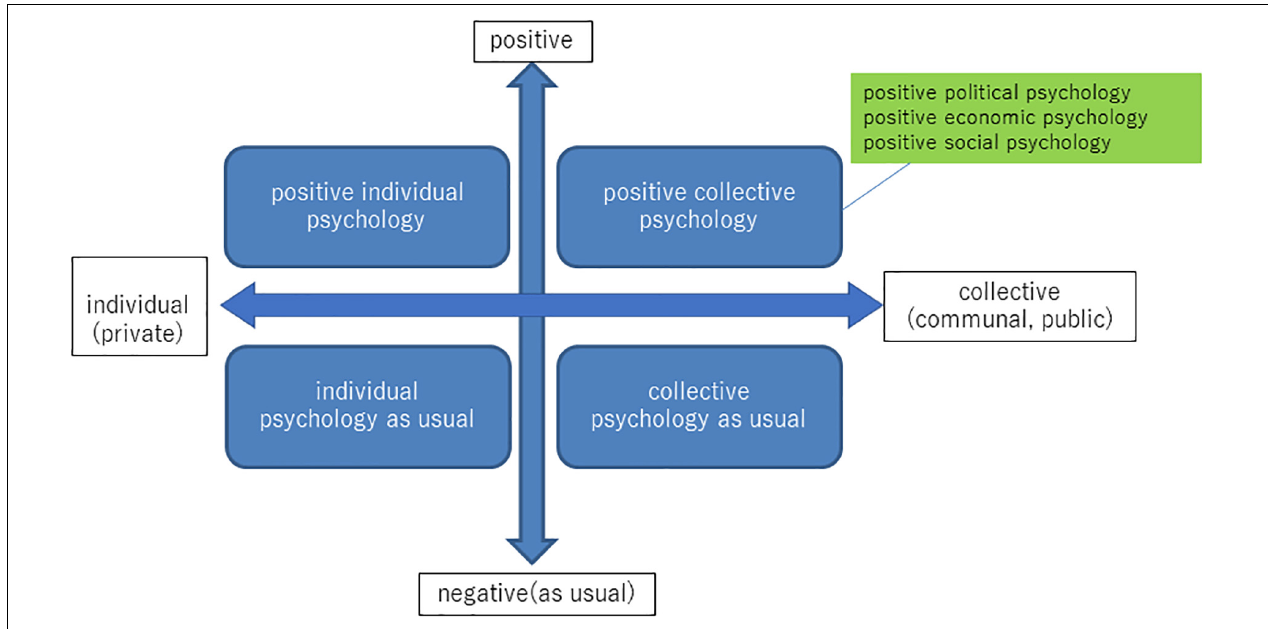
FIGURE 1 | Positive individual/collective